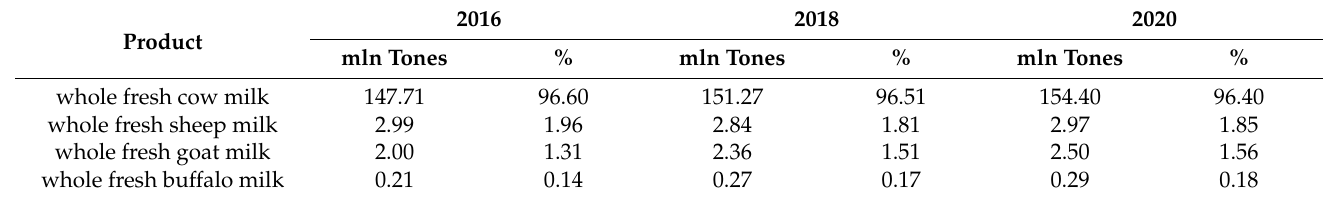
Table 1. Milk market share statistics for 2016–2020 in 27 European Union countries. Adapted from [20].